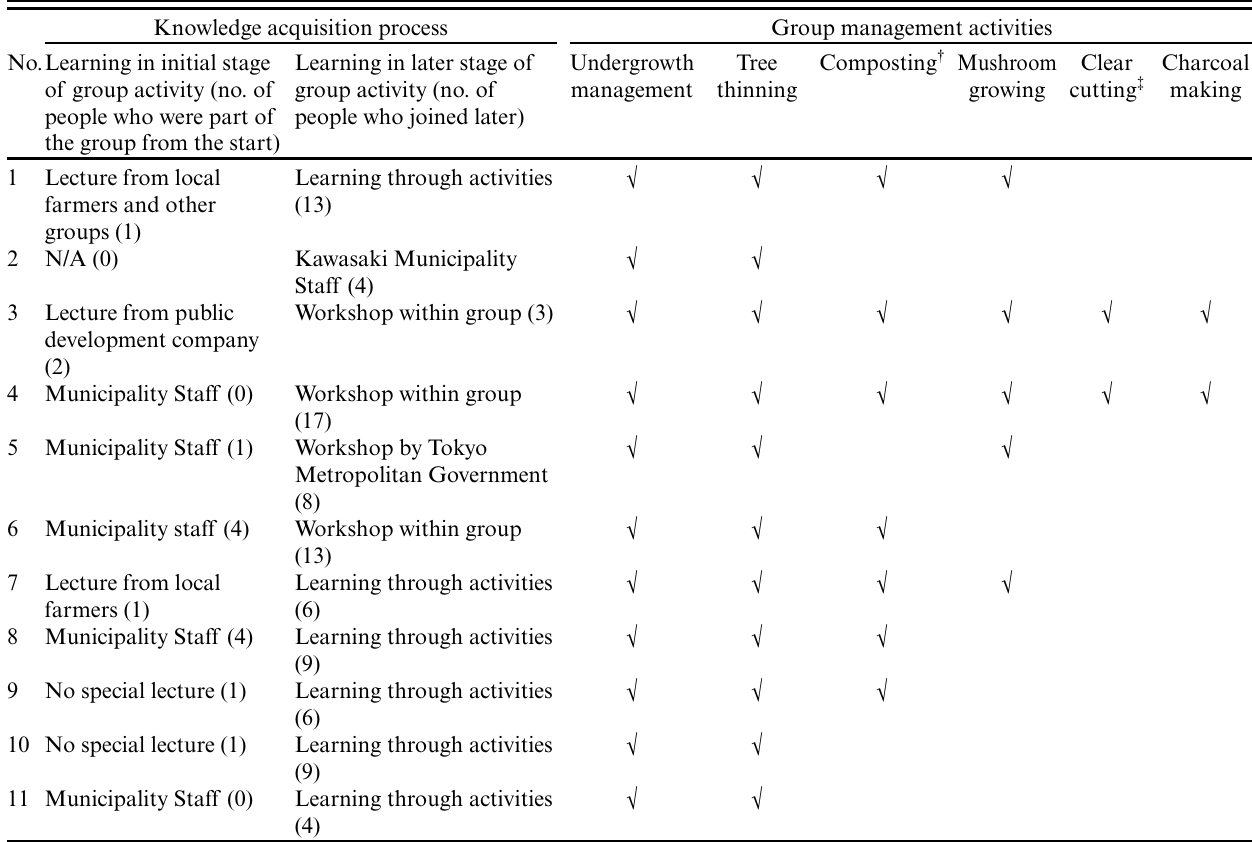
Table 4 . Management activities and learning processes in community